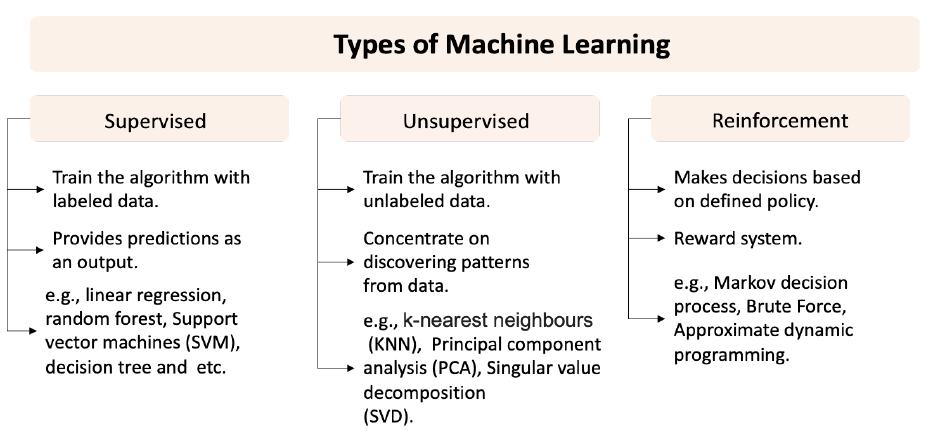
Figure 7. Overview of the ML types that can be used for different applications, supervised, unsupervised and reinforcement learning. Table 2. ML approaches that can be used in Biomaterials and TE